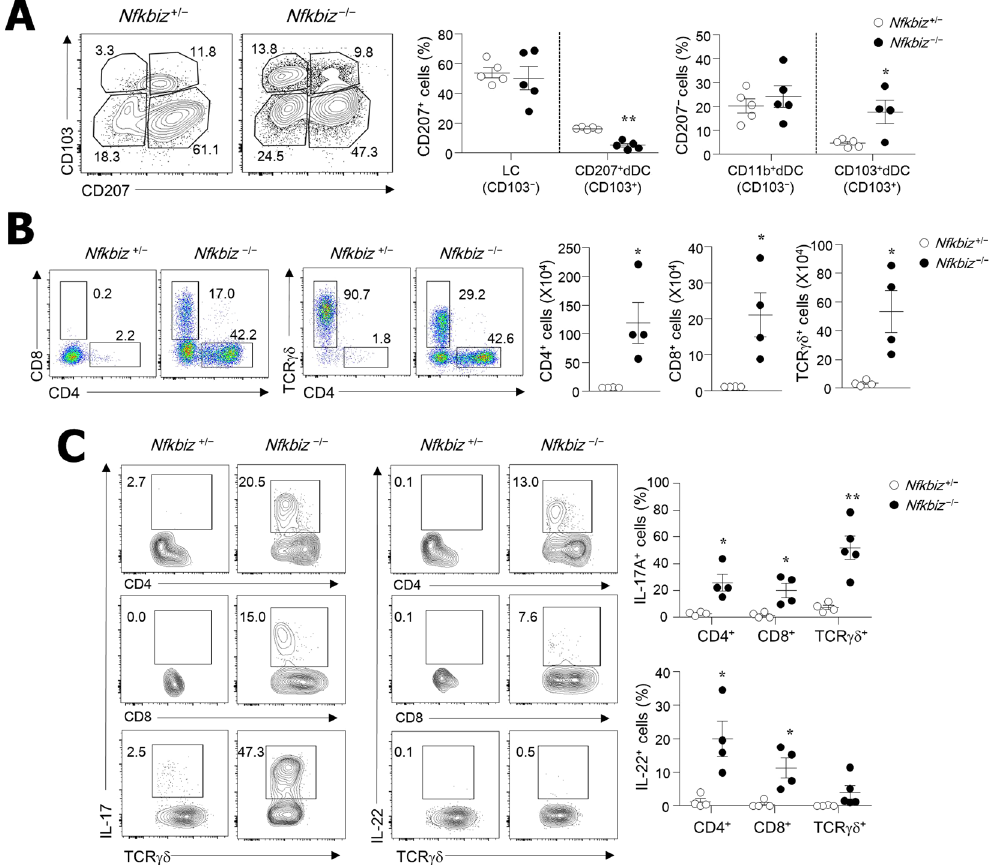
Figure 2. IL-17A- and IL-22-secreting T cells infiltrate into skin of Nfkbiz − / − mice. Flow cytometry analysis of ( A ) DC subsets in CD45 + MHCII + CD11c + cells and ( B ) T cells in skin of Nfkbiz + / − and Nfkbiz − / − mice. ( C ) IL- 17A and IL-22 production from each cell subset after gating CD45-positive skin cells. Data are representative of three independent experiments. * p < 0.05, ** p <